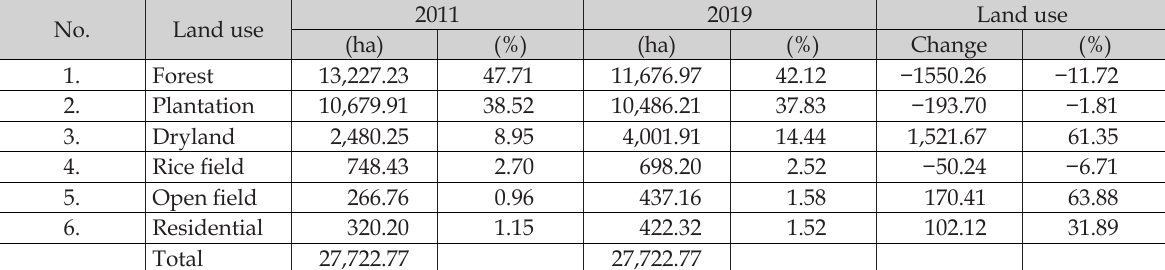
Table 2. Changes in land use in the Sanenrejo sub-watershed for the period 2011–2019. No. land use